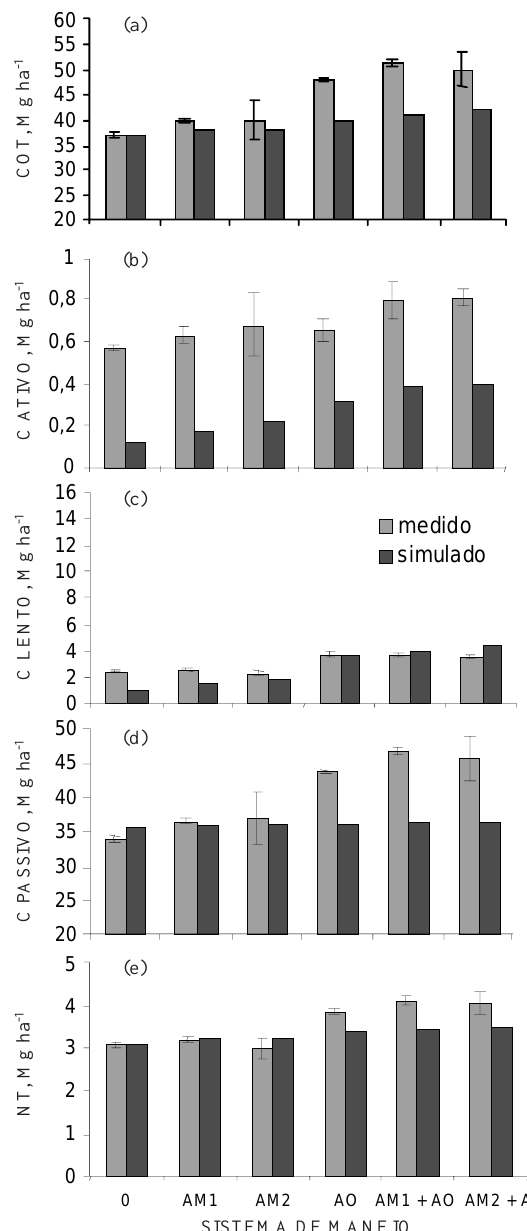
Figura 6. Comparação dos estoques de carbono or- gânico total (COT) (a), dos compartimentos de carbono ativo (b), lento (c) e passivo (d) e do nitrogênio total (NT) (e), medidos e simulados pelo modelo Century nos seguintes tratamen- tos: 0: testemunha; AM1: 250 kg ha -1 de 4-14-8 + 20 kg ha -1 de N em cobertura; AM2: 500 kg ha -1 de 4-14-8 + 40 kg ha -1 de N em cobertura; AO: adubo orgânico, 40 m 3 ha -1 ; AM1 + AO e AM2 + AO. Para valores medidos, n =